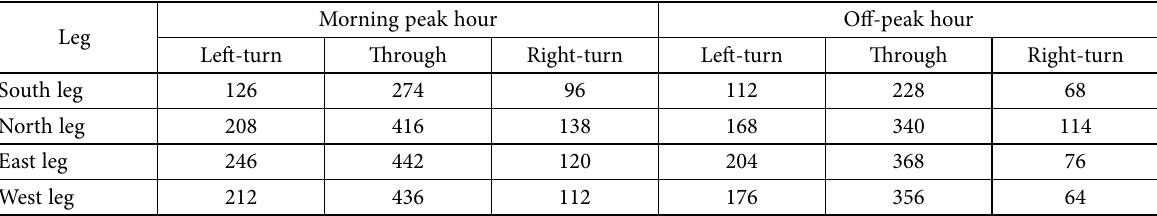
Fig. 3. The channelization of Elizabeth Street and La Trobe Street intersection Table 1. The traffic volumes obtained from field experiment